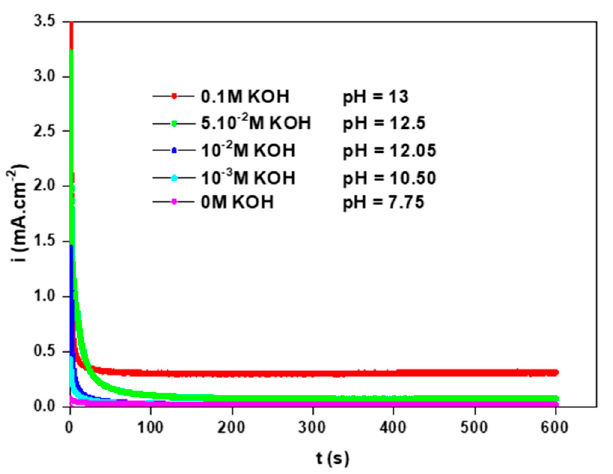
Figure 5. pH effect on synthesis by chronoamperometry of the poly-ATT.